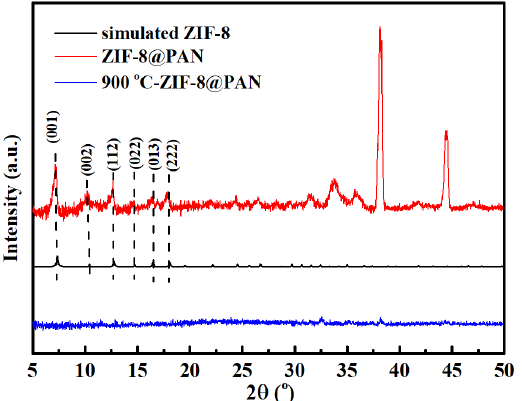
Figure 4. XRD patterns of the ZIF−8@PAN nanofiber membrane, the simulated ZIF−−8, and the carbonized ZIF−8@PAN nanofiber membrane.